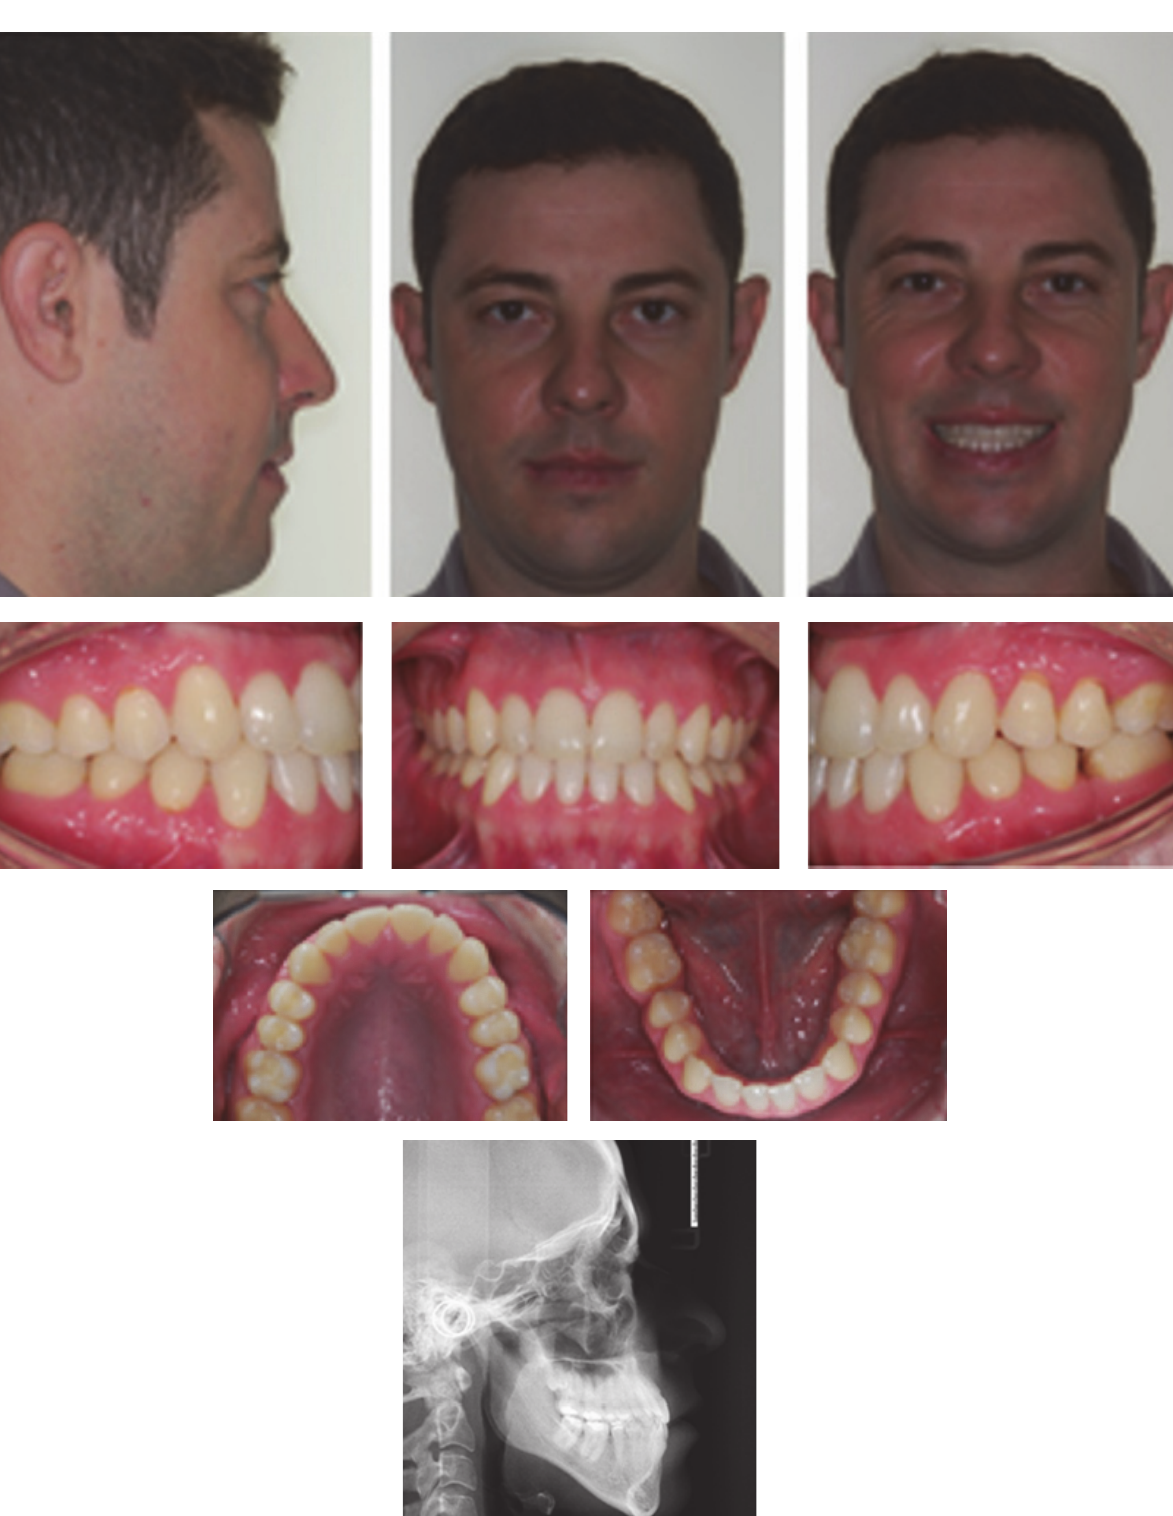
Figure 8: Posttreatment facial and intraoral photographs, and cephalometric radiograph (2 years after treatment